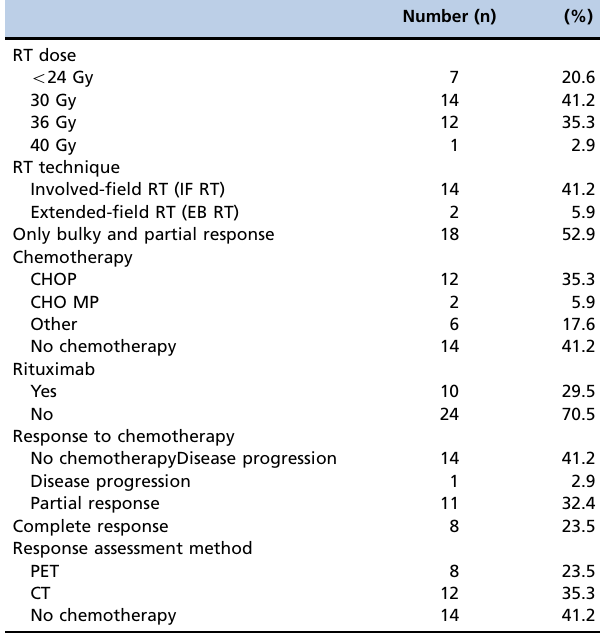
Table 2 - Radiotherapy and